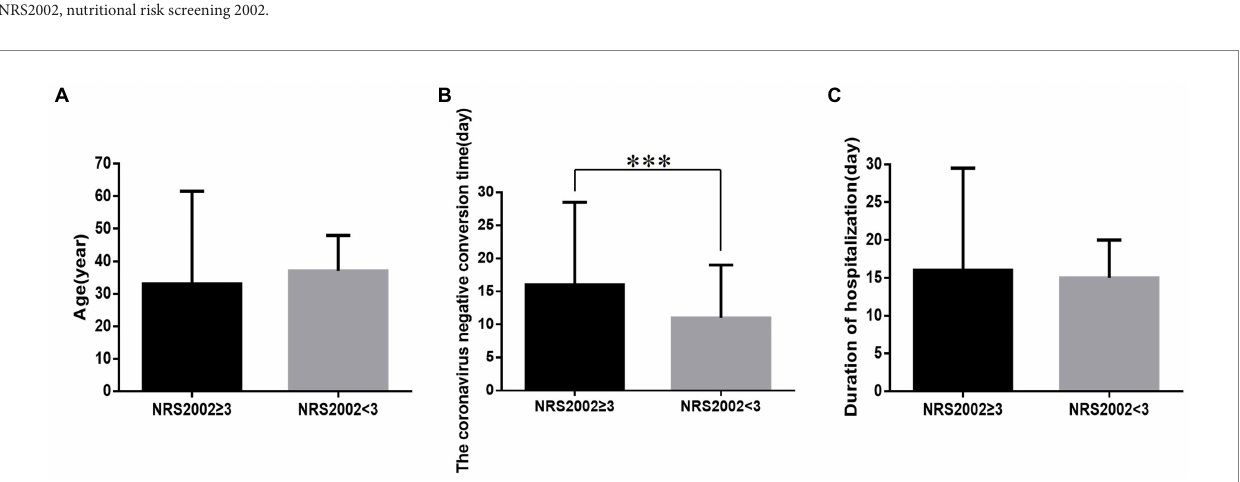
FIGURE 1 Comparison of age, the coronavirus negative conversion time and duration of hospitalization between NRS2002 ≥ 3 group and NRS2002 < 3 group (n = 1,228; NRS2002 ≥ 3 and NRS2002 < 3 groups, n = 97 and 1131, respectively). (A) Age. (B) The coronavirus negative conversion time. (C) Duration of hospitalization. All variables were presented as median (IQR). Wilcoxon rank-sum tests were used for inter group comparison. ( A,C , p all>0.05; B , p < 0.001) *** p < 0.001.